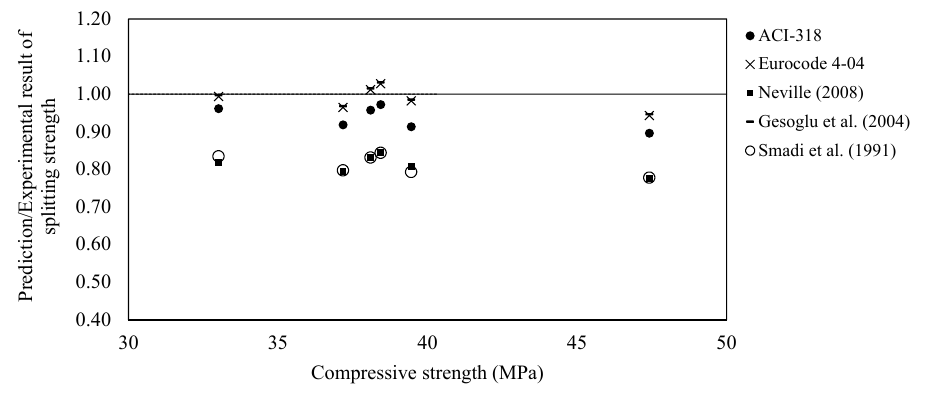
Figure 20. Experimental and theoretical 28-day splitting tensile of POCP concretes. Table 6. Practical equations for splitting tensile strength of concrete.